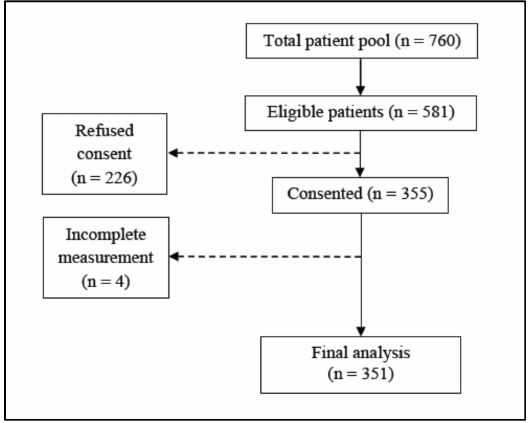
Figure 1. Study flow of patients for recruitment.